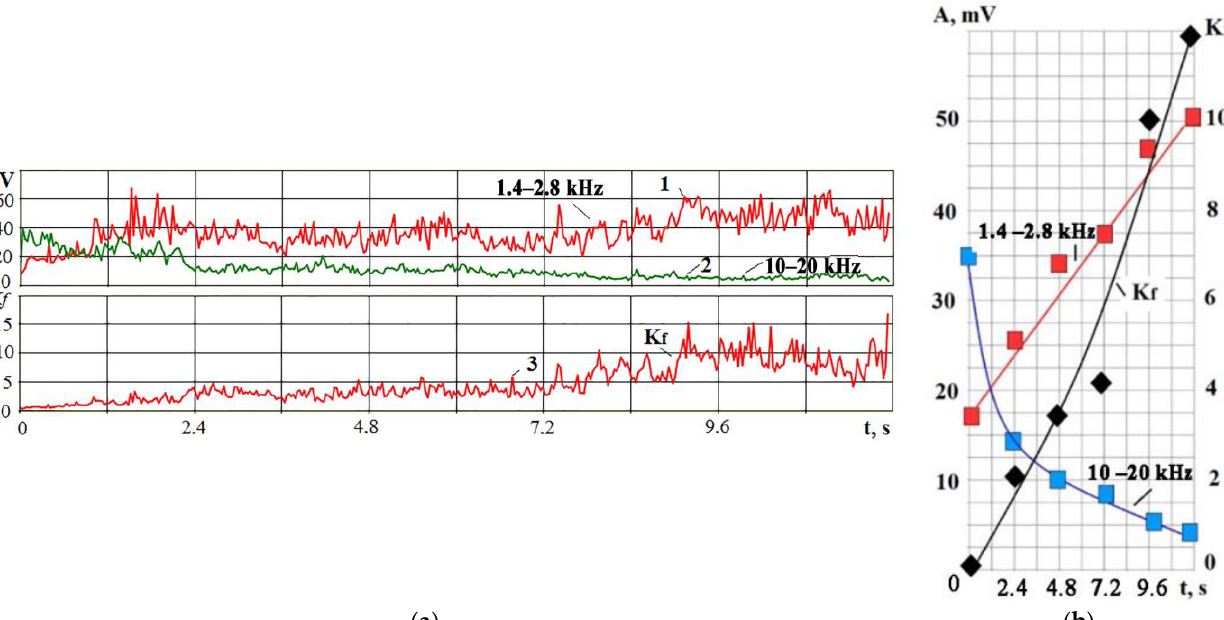
Figure 17. Change of RMS amplitude of VA signals in two frequency ranges (curves 1 and 2 ) and K f parameter (curve 3 ) in time: ( a ) continuous recording of signals in time until the wire tool electrode breakage; ( b ) the result of RMS averaging of the record divided into 6 intervals.